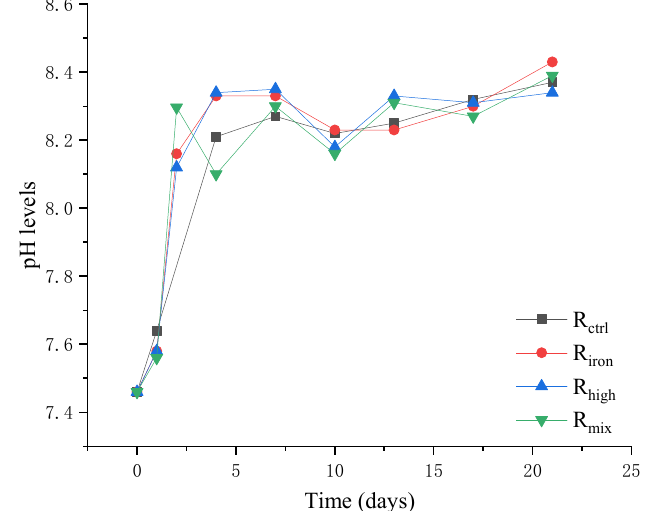
Figure 3. pH levels of the four reactors.